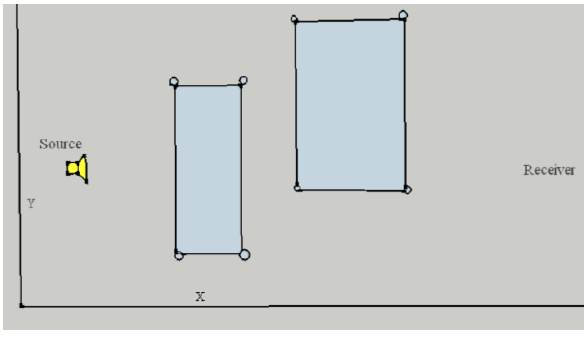
Figure 8. Potential points and edges (projected to X-Y) to be used for determining effective diffracting points around sides